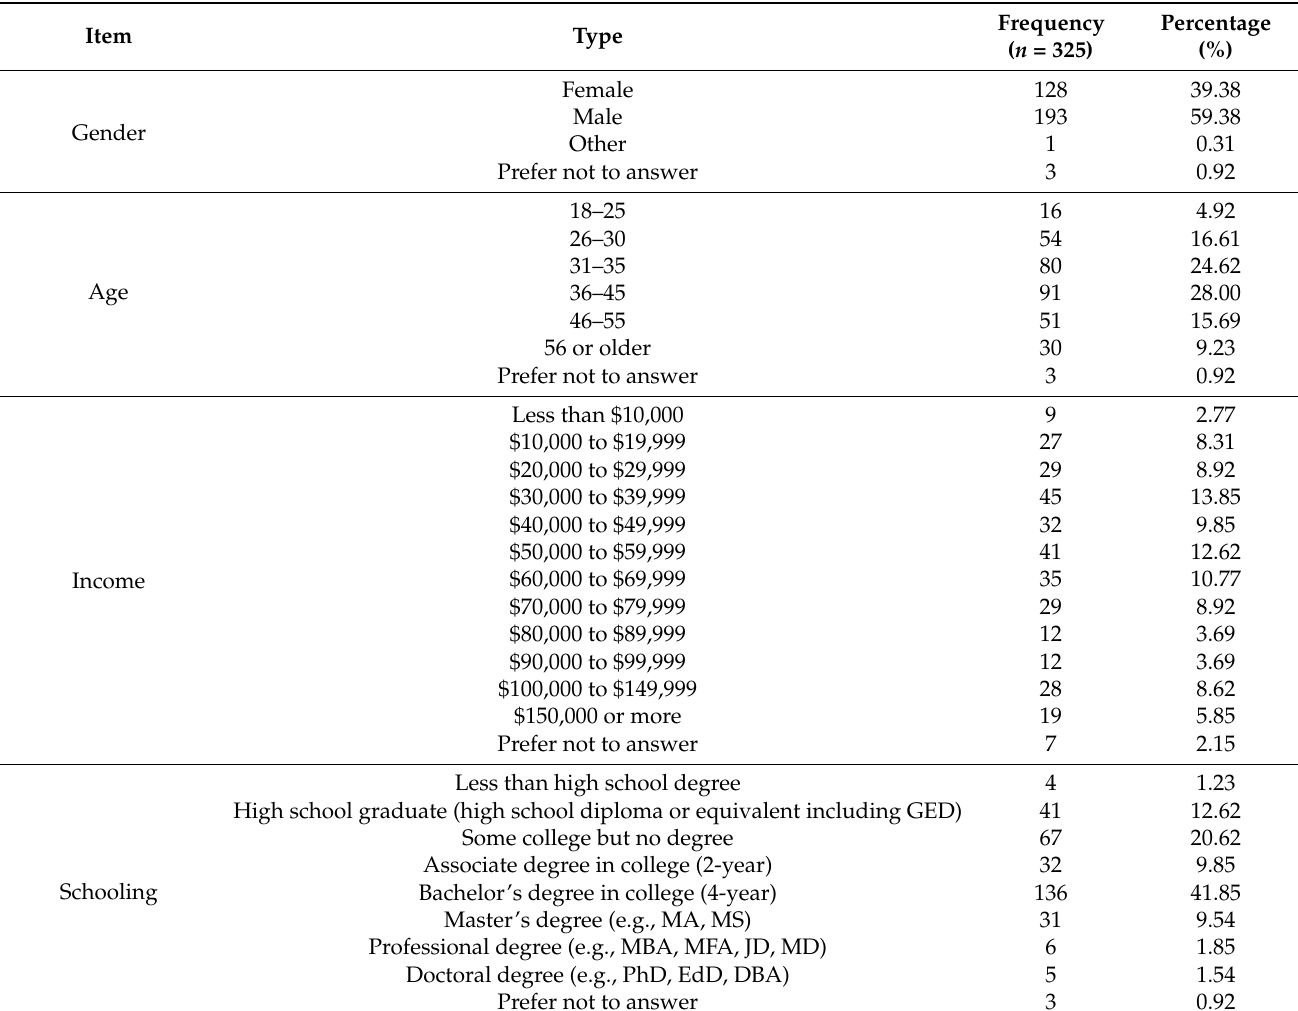
Table 1. Demographic Profile of